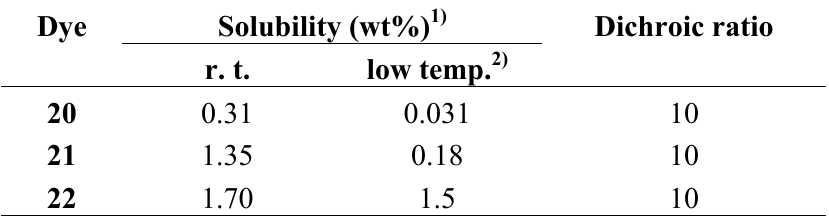
Table 7. Solubilities and dichroic ratios of magenta anthraquinone dichroic dyes with phenylthio groups at the 1, 4, 5 and 8